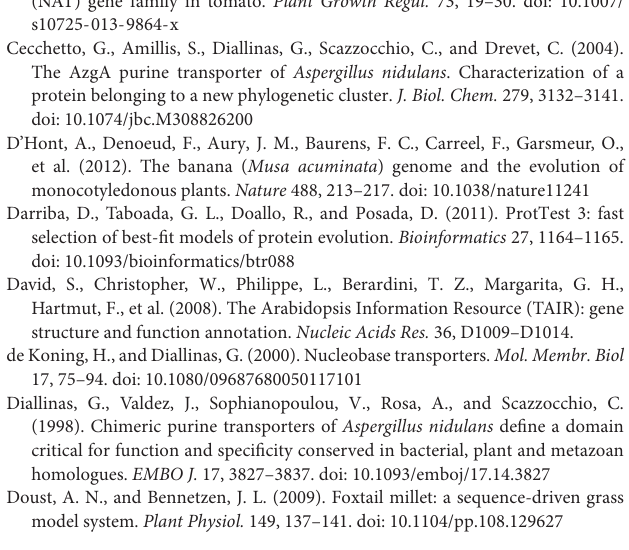
TABLE S3 | The genes in different NCS2